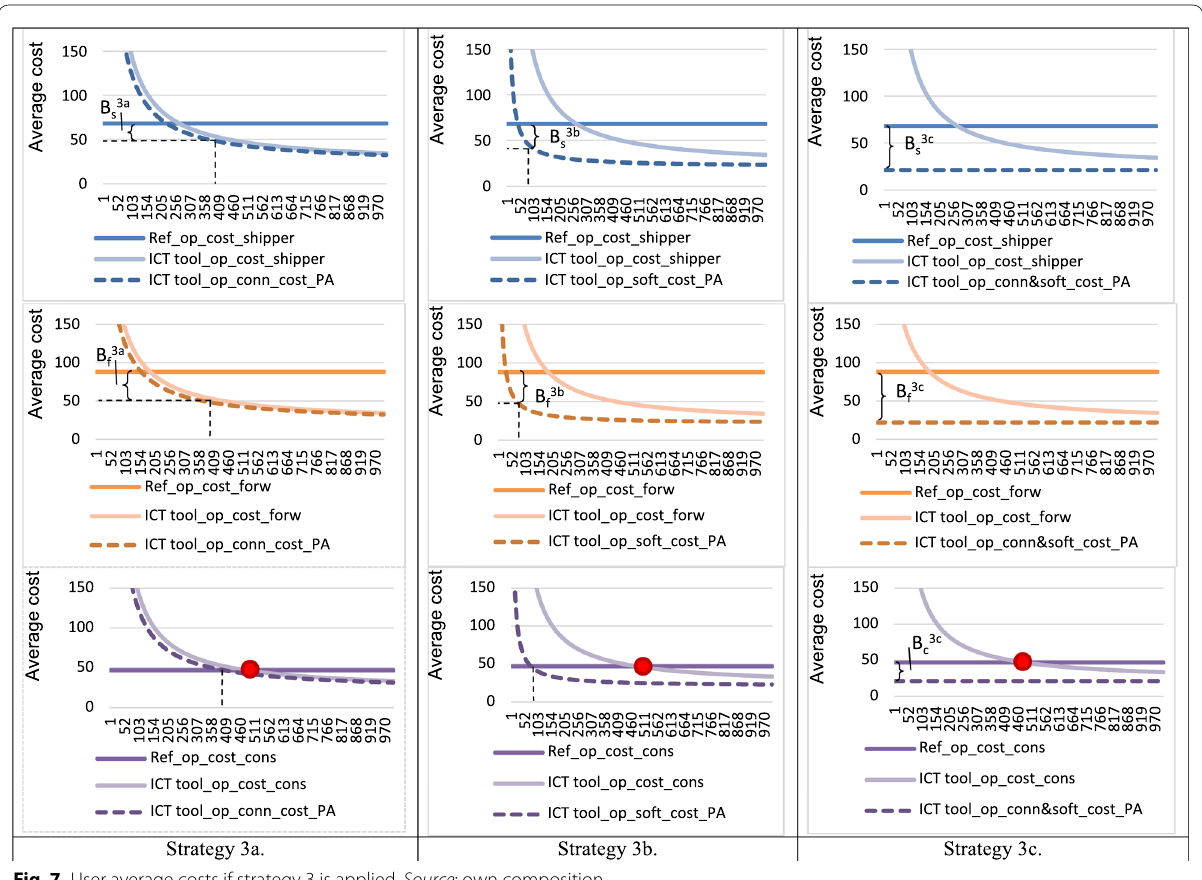
Fig. 7 User average costs if strategy 3 is applied. Source : own composition